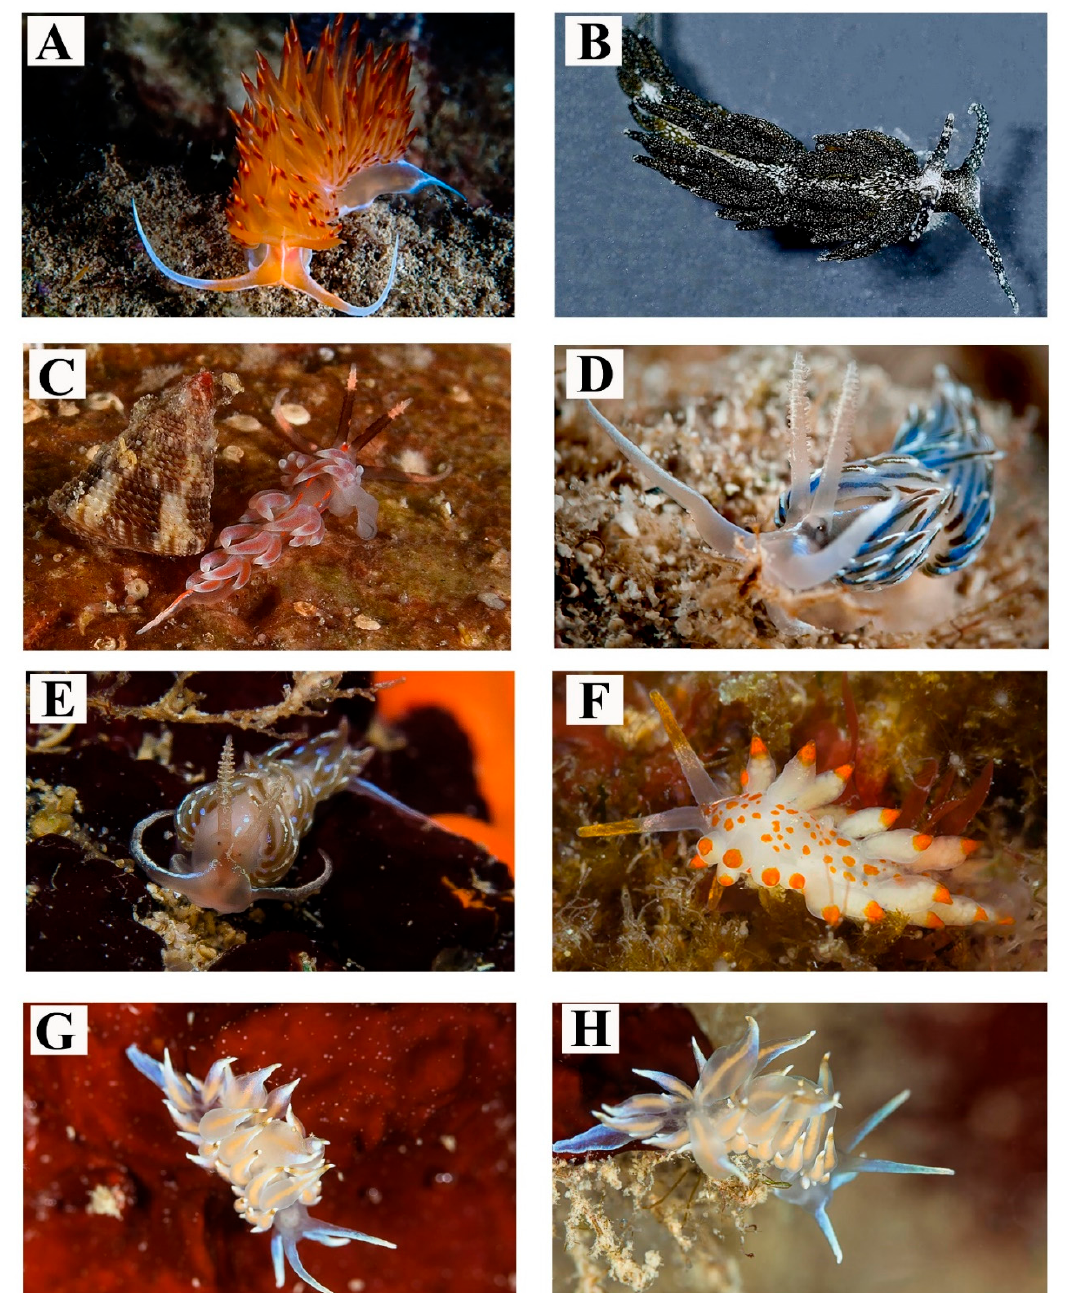
Figure 5. ( A ) Dondice banyulensis . St. 13 ( B ) Facelina fusca . St. 7 ( C ) Facelina rubrovittata . St. 11 ( D , E ) Figure 5. A. Dondice banyulensis . St. 13 B. Facelina fusca . St. 7 C. Facelina rubrovittata . St. 11 D. E. Facelina Facelina vicina . St. 11 ( F ) Eubranchus cf. farrani . St. 11 ( G , H ) Eubranchus cf. linensis St. vicina . St. 11 F. Eubranchus cf. farrani. St. 11 G. H. Eubranchus cf. linensis St. 11.